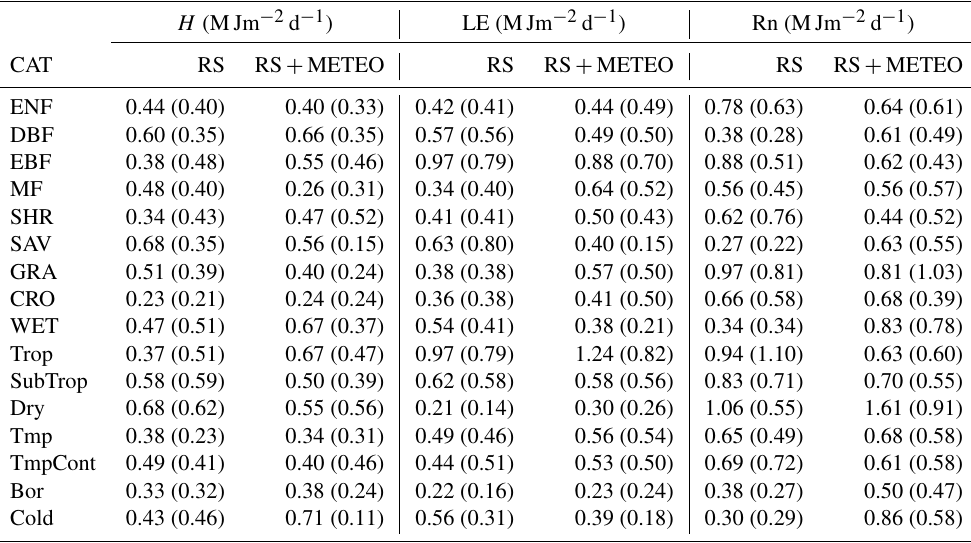
Table C6. Median site-by-site absolute bias and its standard deviation (in parentheses and estimated as reported in Jung et al., 2009) for the energy fluxes. List of acronyms: ENF, was evergreen needleleaf forest; DBF, deciduous broadleaf forest; EBF, evergreen broadleaf forest; MF, mixed forest; SHR, shrubland; SAV, savannah; GRA, grassland; CRO, cropland; WET, wetland; Trop, tropical; SubTrop, subtropical; Dry, dry and arid land; Tmp, temperate; TmpCont, temperate–continental; Bor, boreal; Cold, cold and polar environment or covered by